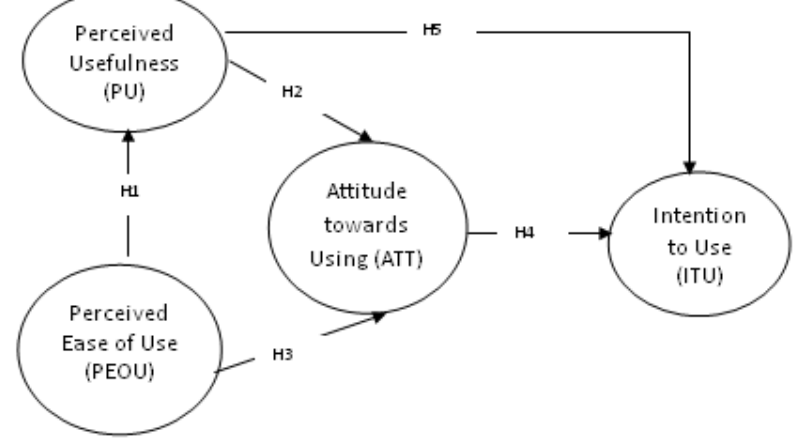
Figure 4 Conceptual research